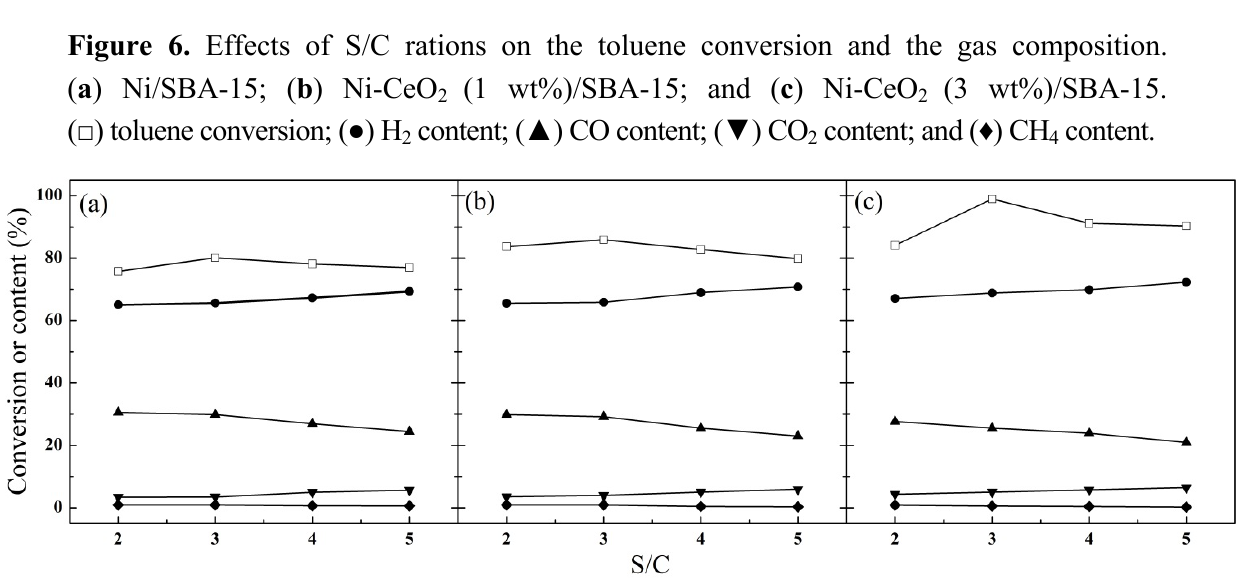
(1 wt%)/SBA-15; and ( c ) Ni-CeO 2 content; ( ▲ ) CO content; ( ▼ ) CO 2